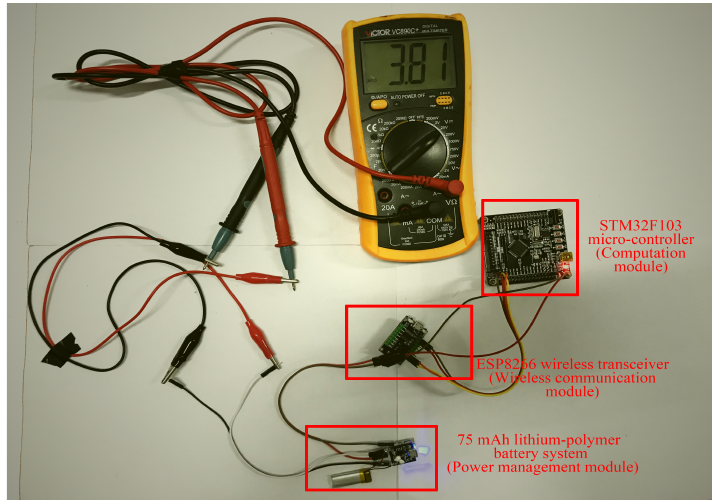
Figure 7. A photograph of the wireless node.